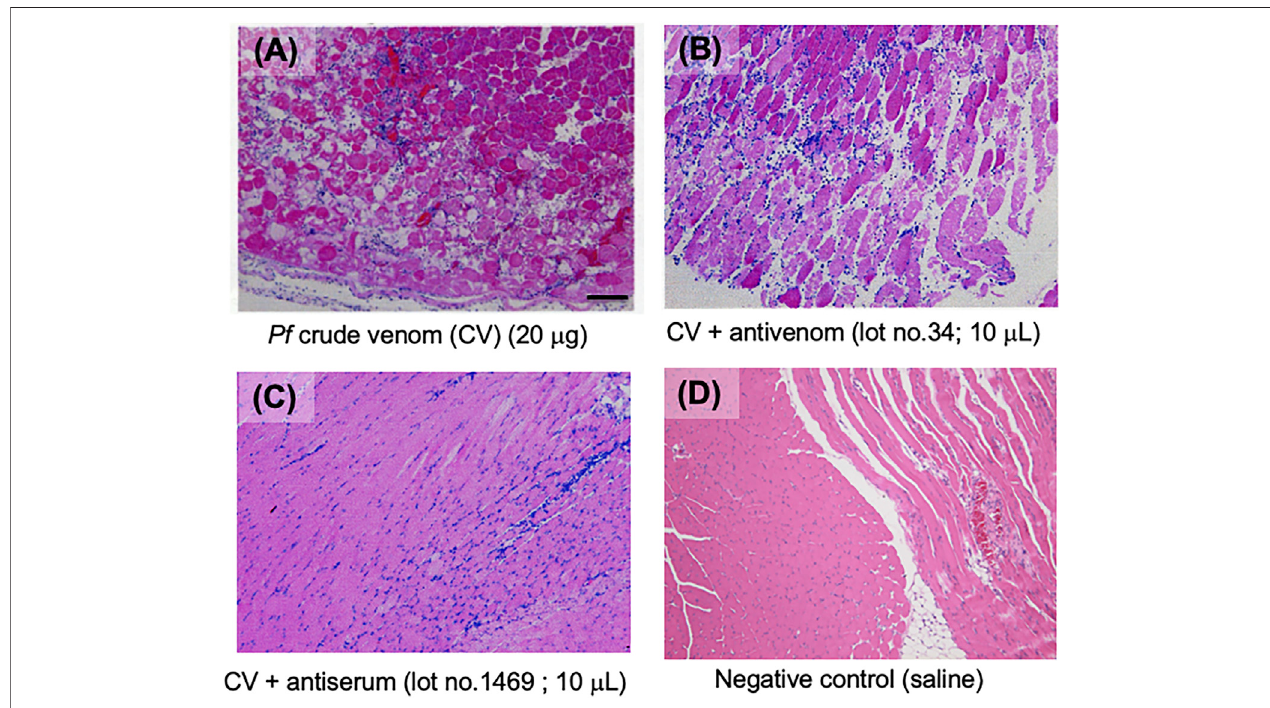
FIGURE 1 | Anti-necrosis activities of the antivenom. Haematoxylin and eosin (H&E)-stained sections of mice femoral region injected with habu crude venom (A) , crudevenom+antivenom(lotno.34) (B) ,andcrudevenom+antivenom(lotno.1469) (C) wereanalyzedhistologicallyunderalightmicroscope.Allimagesarethesame magni fi cation. Scale bar (cid:2) 100 μ